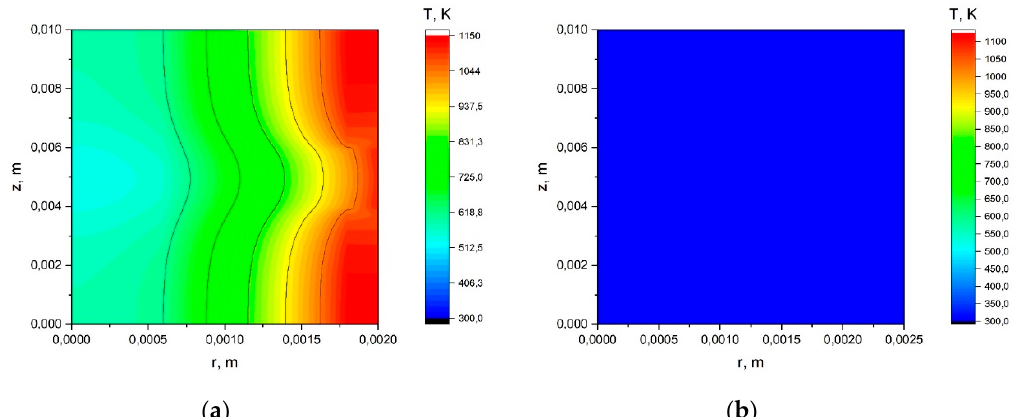
Figure A19. Temperature distribution in the stem of a herbaceous plant: R = 0.002 m, t = 6 s, q = 30 kW/m 2 ( a ); R = 0.0025 m, t = 0.5 s, q = 0.5 kW/m 2 ( b ).